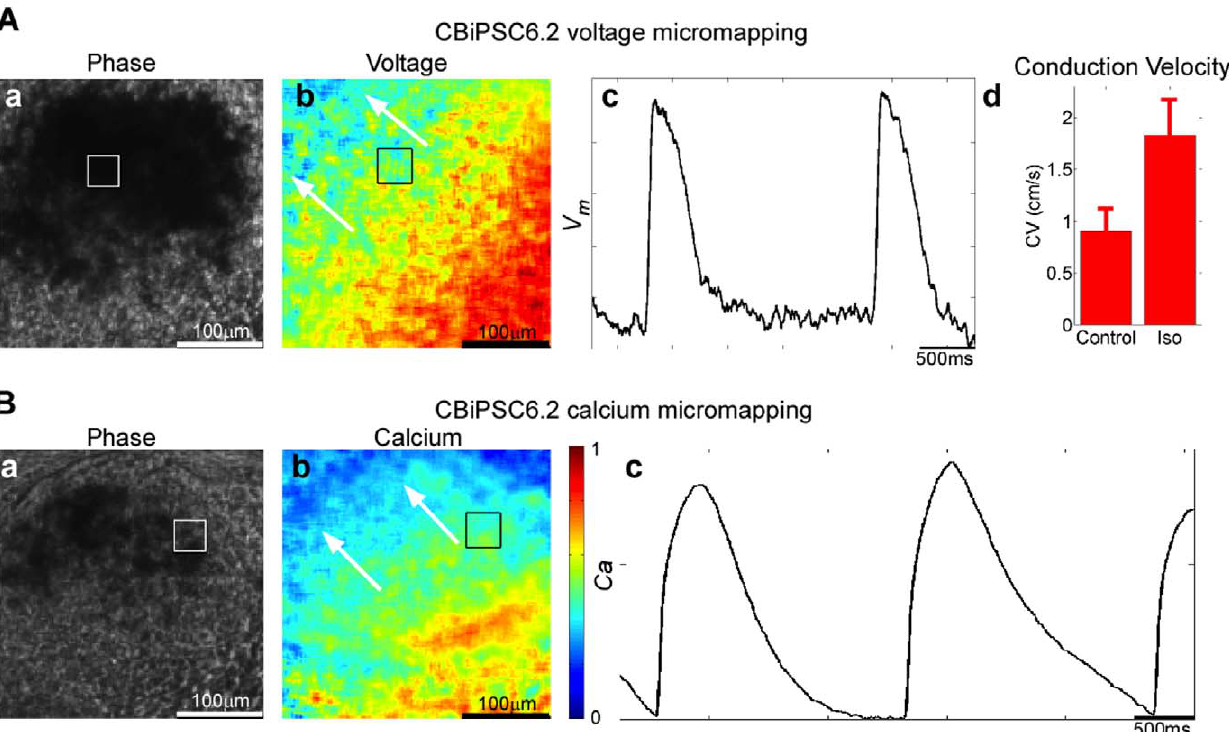
Figure 8. Electrophysiological characterization non-viral cord blood-derived hiPSC contracting hEB differentiated using optical mapping. ( A ) Voltage micromapping. Phase image of CBiPSC6.2 hEB at 4 6 magnification. b. Voltage map, hEB were stained with di-4-ANEPPS (a voltage-sensitive fluorescent dye), and electrically field-stimulated at the same pacing rate (arrows indicate direction of electrical wave propagating across hEB). c. Action potentials during 0.5 Hz field stimulation. d. Average conduction velocity (CV) measurements (mean 6 standard deviation) for control and 15 min after addition of 50 m M isoproterenol during 0.5 Hz field stimulation. ( B ) Calcium micromapping. a. Phase image of beating hEB. b. Calcium map (arrows indicate direction of calcium wave propagating across beating hEB). c. Representative calcium transient (Ca) waveforms during 0.5 Hz field stimulation. Box in a and b denote site of recording in c.